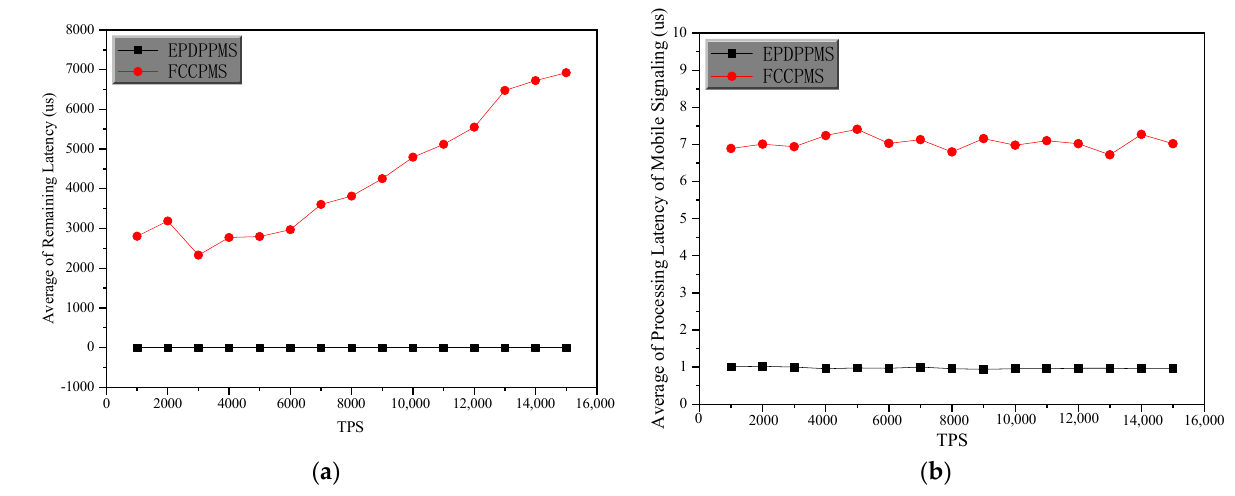
Figure 8. ( a ) Remaining latency. ( b ) processing latency of mobile signaling.